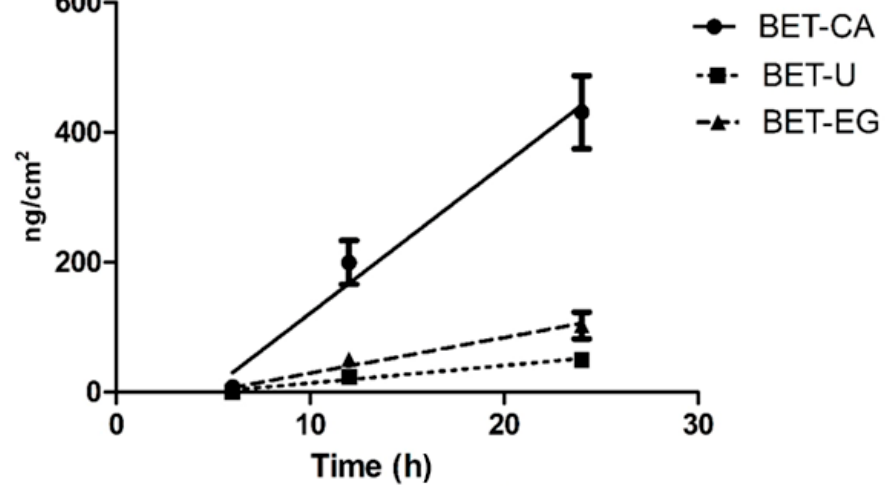
Figure 1. Permeation profiles of the three NaDES formulations (24 h experiment). The cumulative amount permeated per unit area was plotted versus time for the three tested NaDES extracts and their permeability profiles at 37 ◦ C. The malvidin amounts passed through the porcine ear skin (expressed as µ g/cm 2 ) and the steady state flux J are reported for each tested formulation at the selected temperature. The values reported are the means of at least five independent experiments.